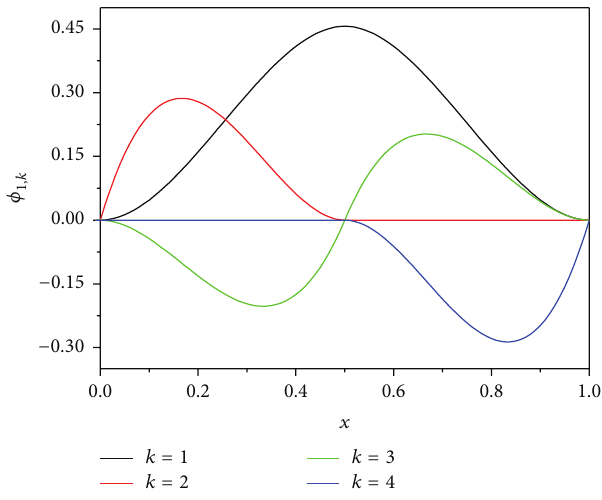
Figure 1: Scaling functions in scaling space 𝑉 1